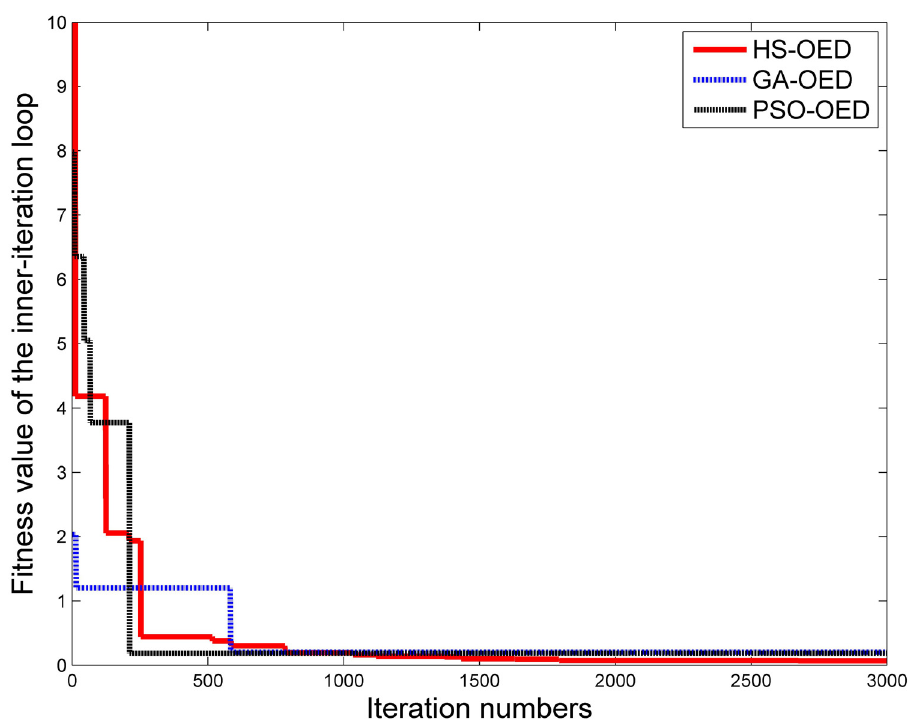
Fig 11. Fitness trajectories of harmony search denoted by HS-OED and two heuristic optimization approaches in the inner iteration loop of OED. The HS-OED algorithm has reduced computational time than GA and PSO algorithm, and obtaining lower output errors in estimating parameter vectors.